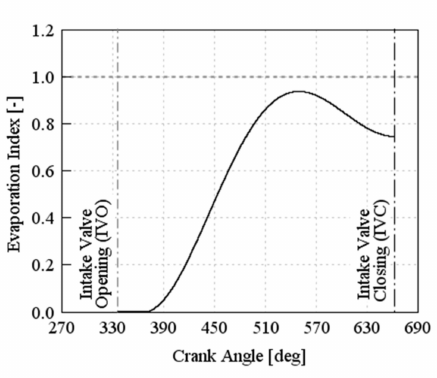
Figure 7. Example of Evaporation Index as a function of Crank Angle